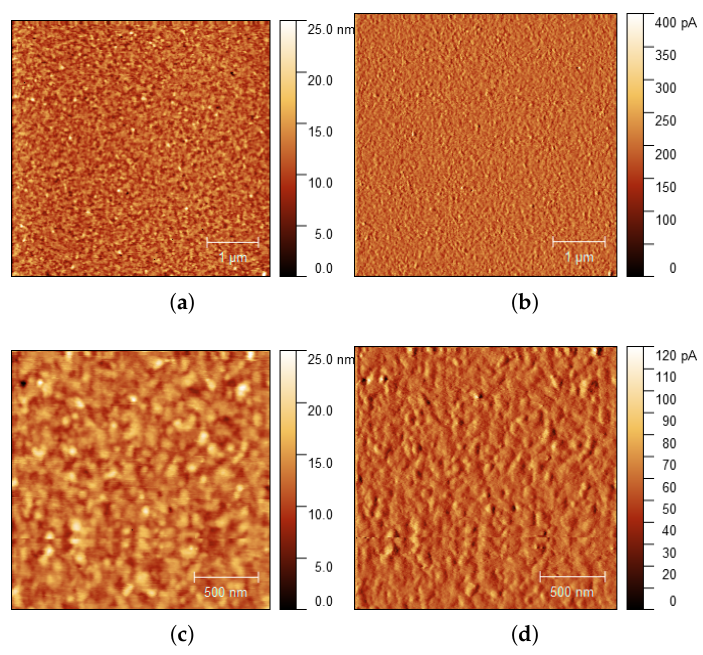
Figure A2. Topography of the 30 nm thickness Au film on mica imaged in AFM constant force mode ( a , c ) and error deflection mode ( b , d ). Average surface roughness R a = 1.71 nm ( a ), 20.84 pA ( b ),